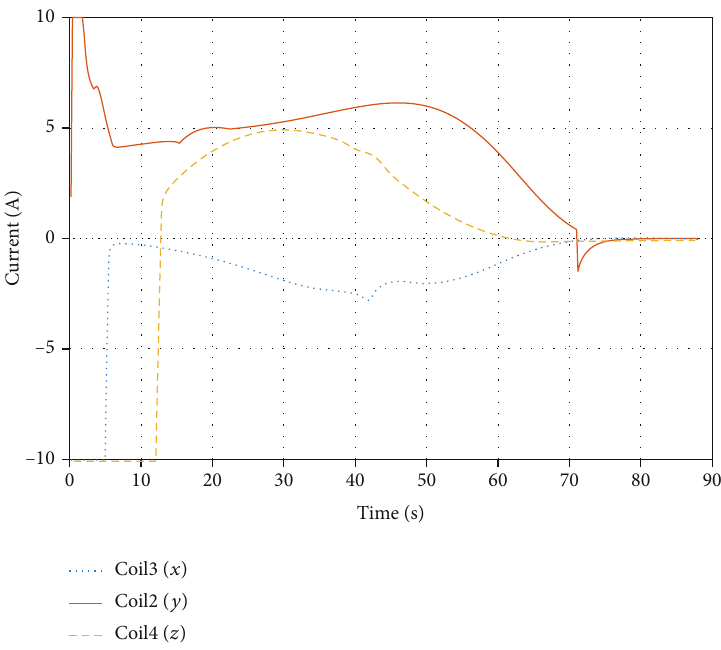
Figure 19: Currents on the coils of Sat2.